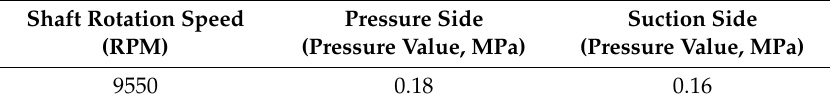
Table 2. Loads applied to all the models.